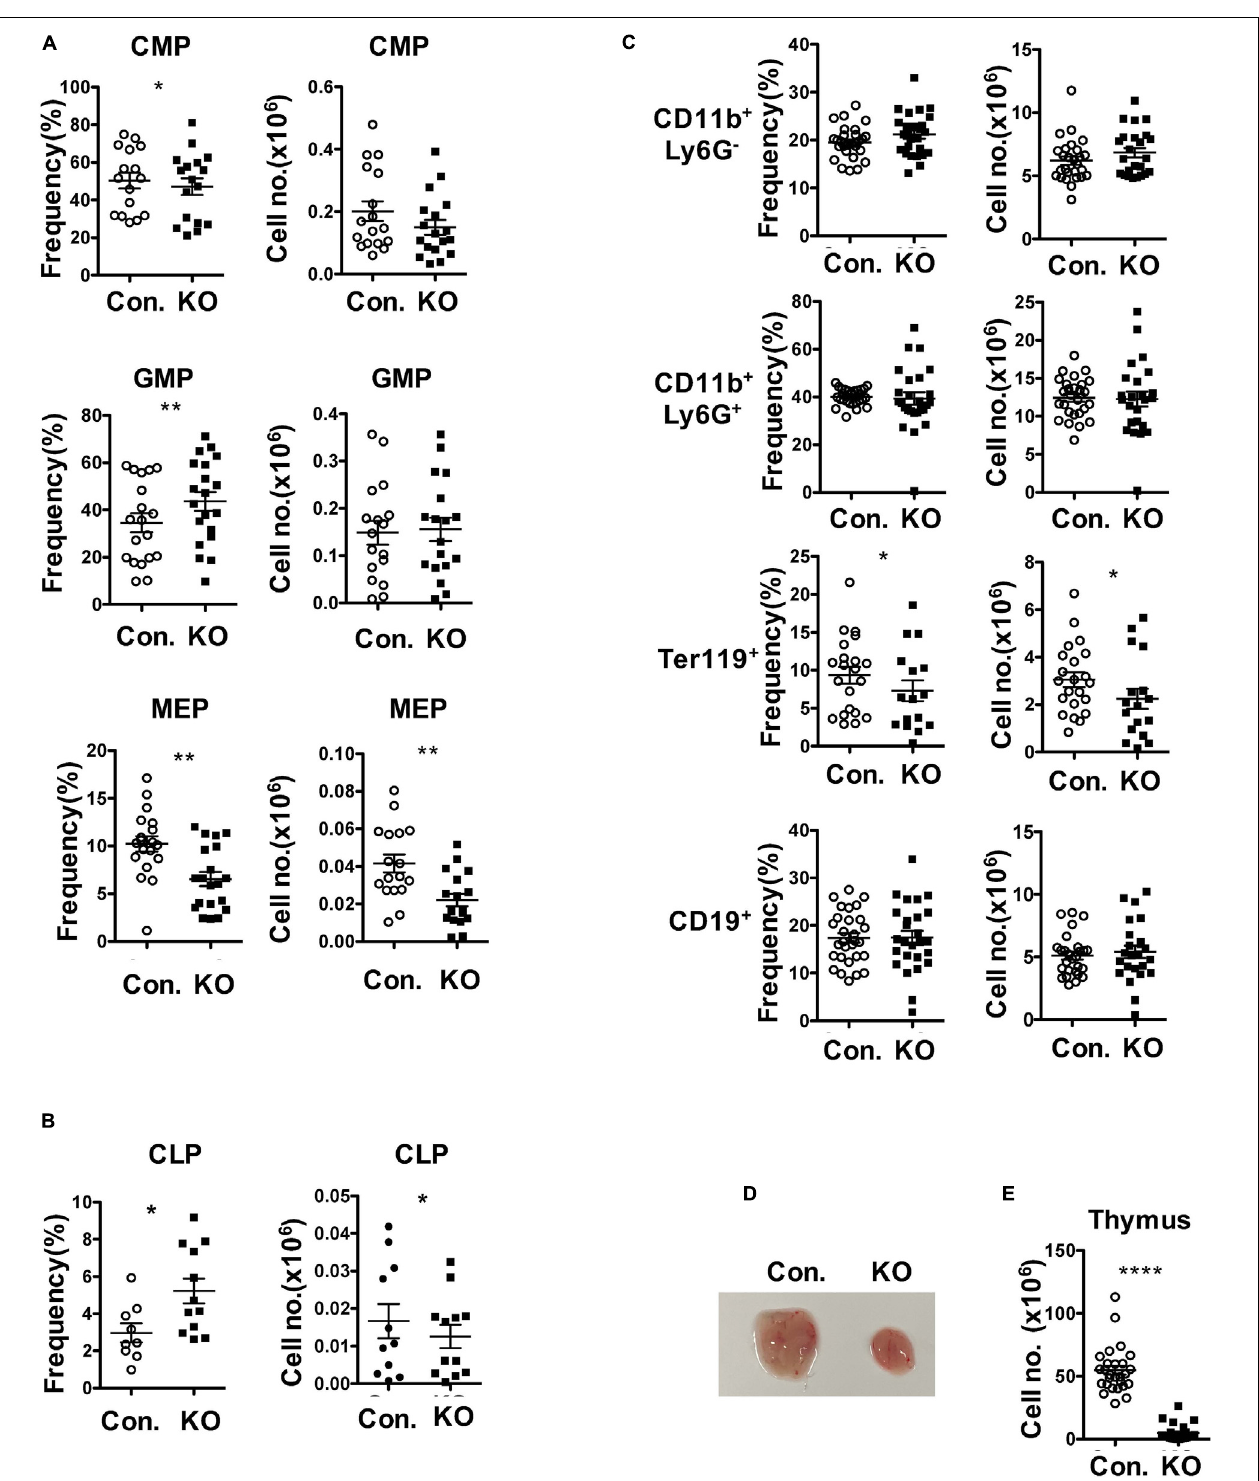
FIGURE 2 | Loss of Rbpj affects lymphoid and erythroid differentiation. (A,B) Frequencies (left) and absolute numbers (right) of CMPs, GMPs and MEPs (A) and CLPs (B) of BM (two femurs and two tibias) from KO and control mice ( n = 10–20). (C) Frequencies (left) and absolute numbers (right) of CD11b + Ly6G − , CD11b + Ly6G + , Ter119 + , and CD19 + subsets in the BM of (two femurs and two tibias) from KO and control mice ( n = 12–25). (D,E) Representative picture showing size (D) and cellularity (E) of thymus from KO and control mice ( n = 25–30). All data represent mean ± SEM. Two-tailed Student’s t- tests were used to assess statistical significance (* P < 0.05; ** P < 0.01; **** P < 0.0001).